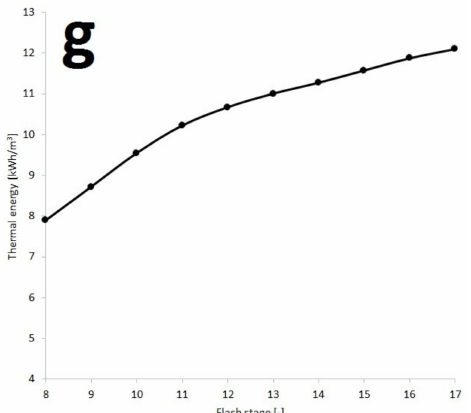
Figure 8. Influence of the number of stages on the water output NaCl ( a ), water output temperature ( b ), water output pressure ( c ), water output flow rate ( d ), consumed steam ( e ), performance ratio ( f ) and thermal energy ( g ).